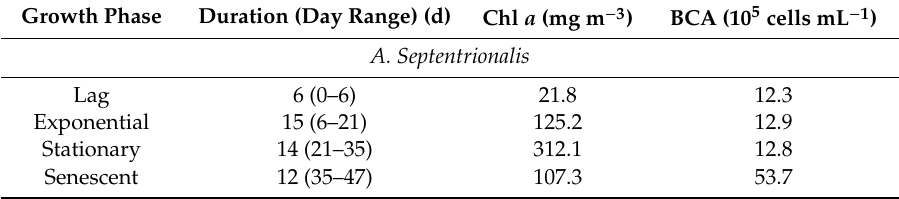
Table 1. Duration and day range of each growth phase of the algal cultures examined, along with the corresponding mean chlorophyll a concentration and mean bacterial cell abundance